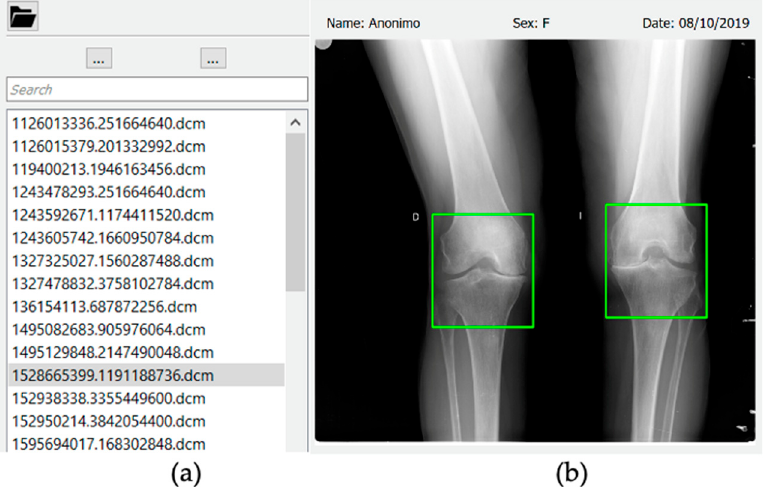
Figure 7. ( a ) Navigation panel, that allows selection of the image to process (*.dcm files). ( b ) The X-ray image panel where the region of interest is selected.